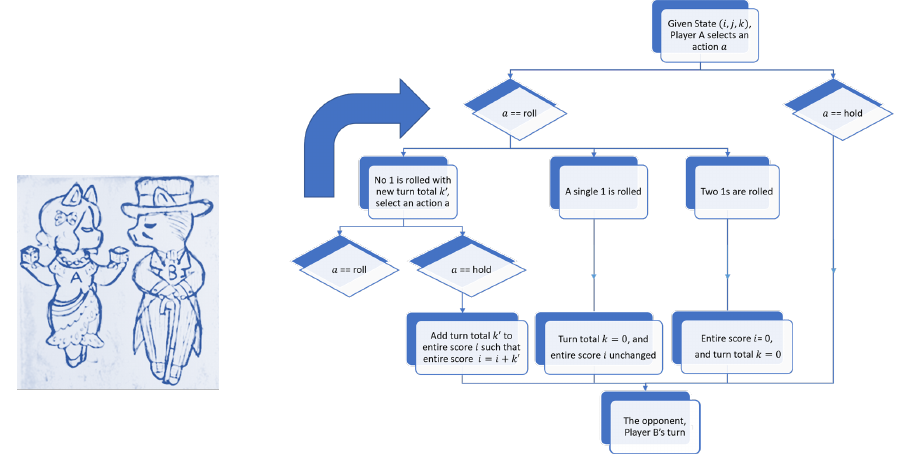
Figure 1. Rules of play for standard two-dice